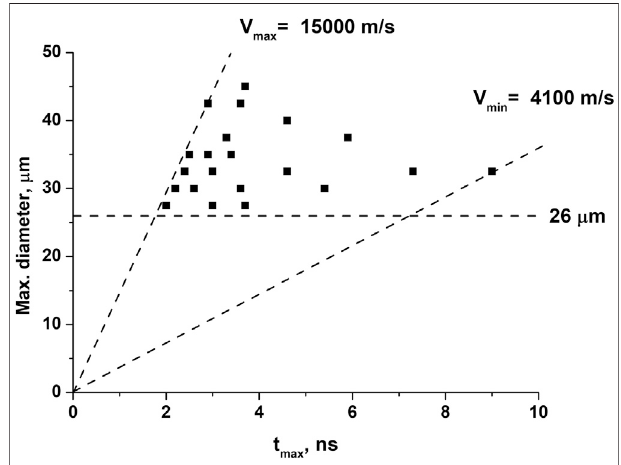
FIGURE4| Dependenceofthemaximumdiameterofplasma fl asheson the time t max . The fi gure shows the maximum and minimum values of the interface